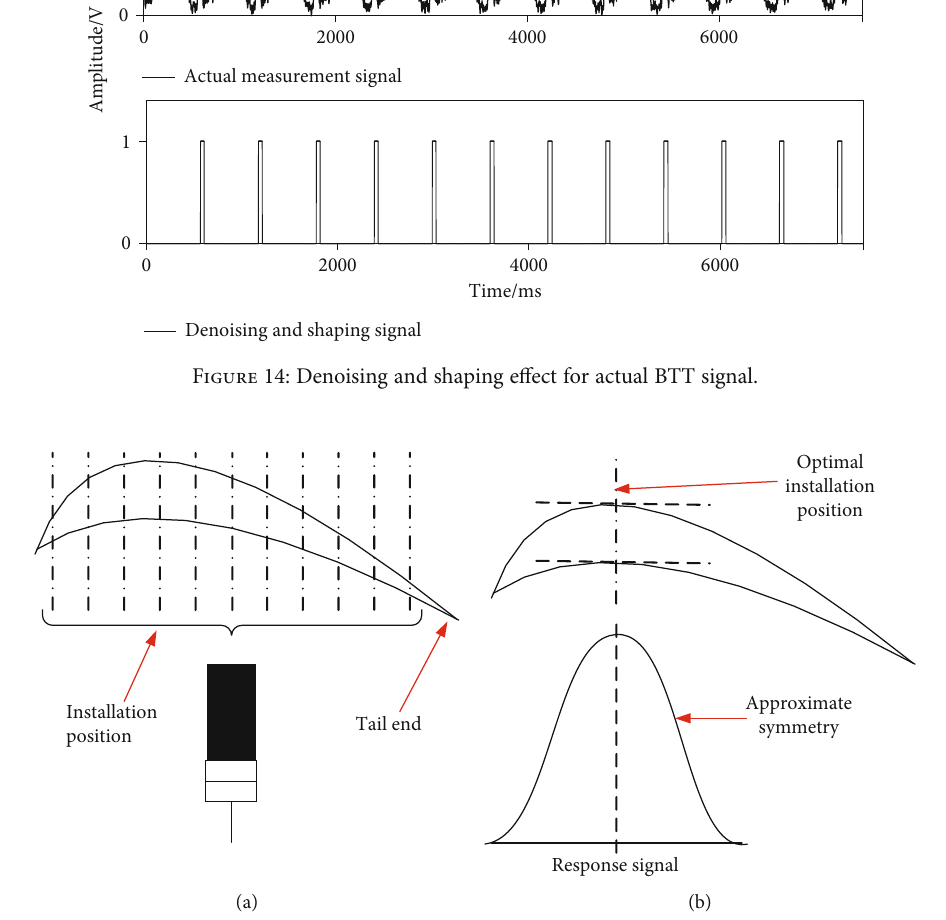
Figure 15: Experiments on the optimal installation position of sensors. Table 2: Experimental